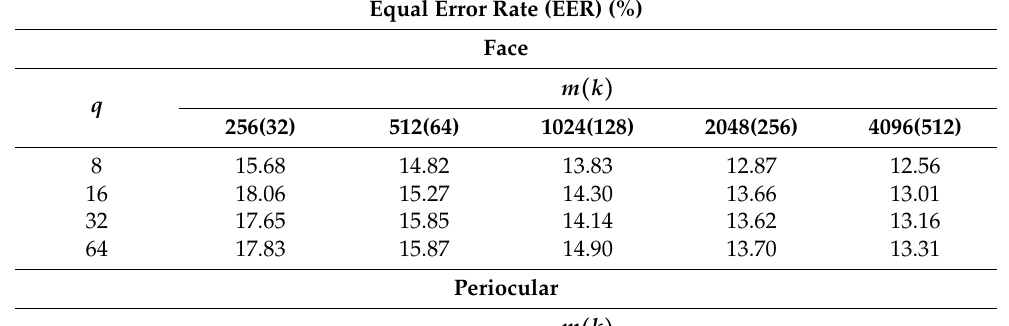
Table 5. Average performance of unimodal and multimodal CB systems on six datasets for varying values of m and q .